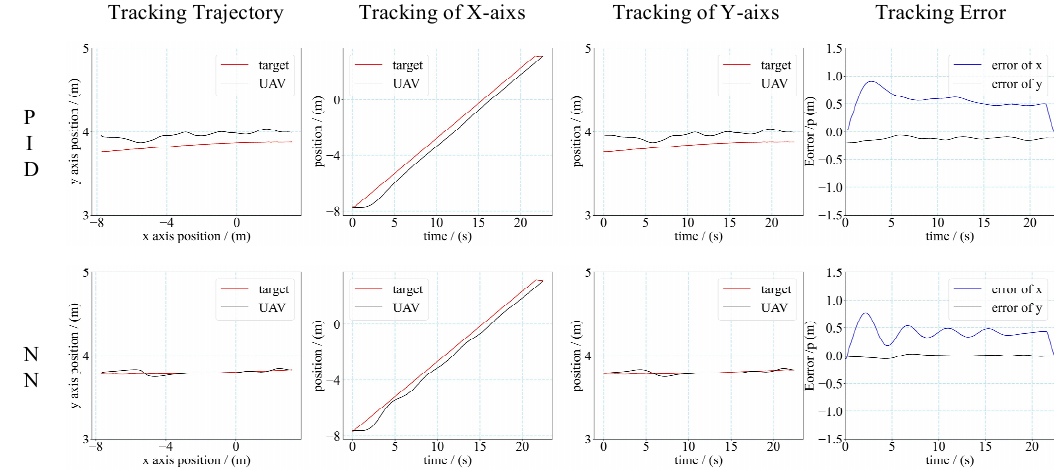
Figure 12. Trajectory and tracking error of UAV tracking target. (Target’s velocity is 0.5 m/s).